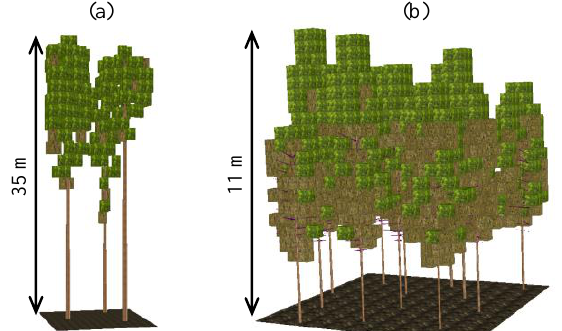
Figure 1. Simplified visualization of the DART scenes for the beech (a) and spruce (b) forest stands. Green represents voxels with foliage only, whereas brown colour indicates voxels with mixed foliage and woody